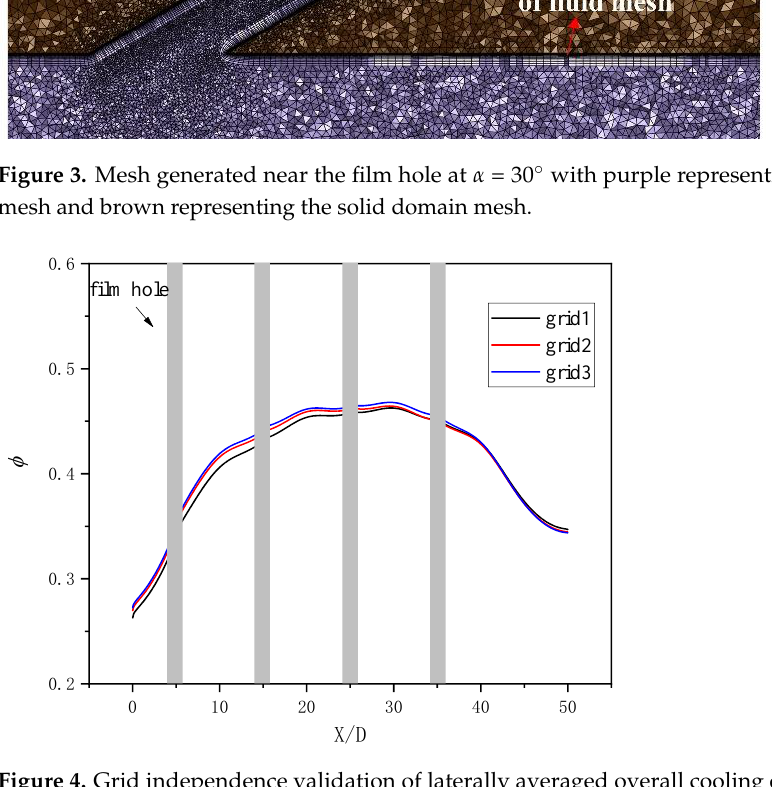
Figure 4. Grid independence validation of laterally averaged overall cooling effectiveness for case with α = 30° at M = 0.5.